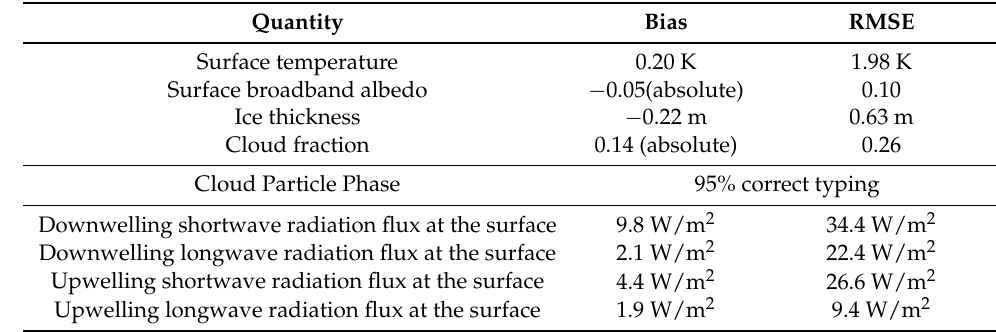
Table 3. Biases and uncertainties (root-mean-square error, RMSE) for some APP-x variables.